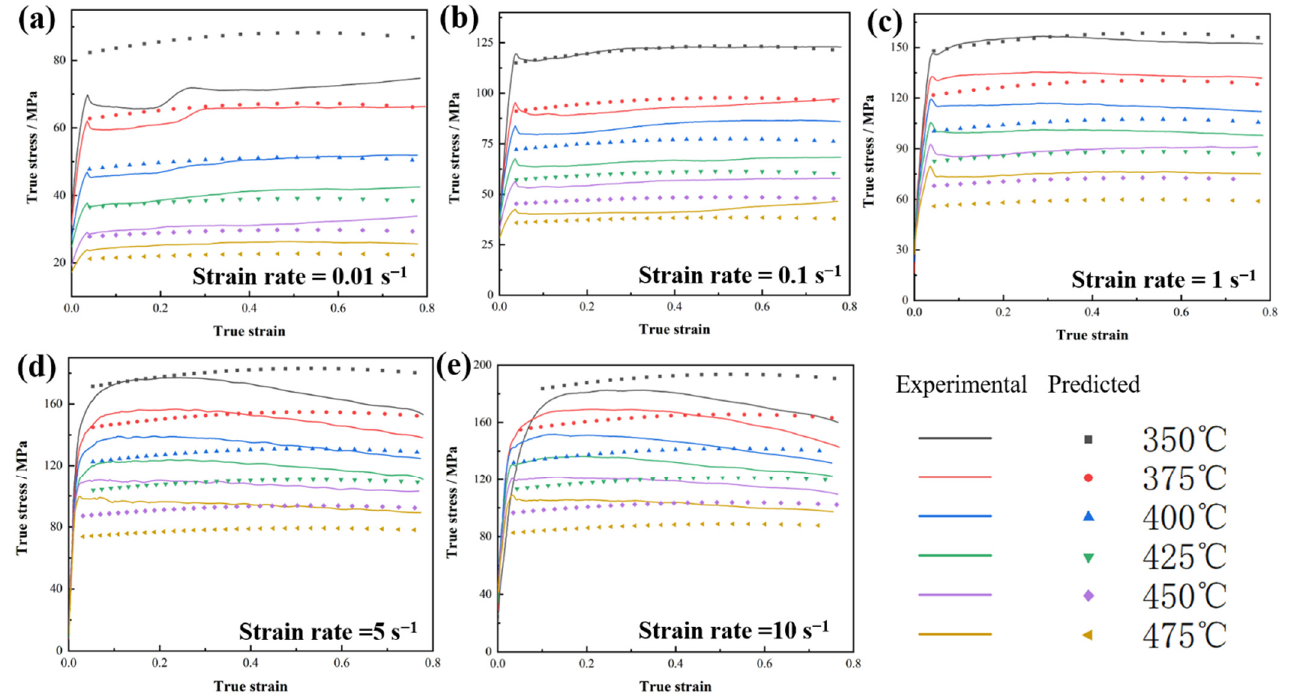
Figure 9. Prediction results of the MJC model with various deformation parameters. ( a ) strain rate = 0.01 s − 1 ; ( b ) strain rate = 0.1 s − 1 ; ( c ) strain rate = 1 s − 1 ; ( d ) strain rate = 5 s − 1 ; ( e ) strain rate = 10 s − 1